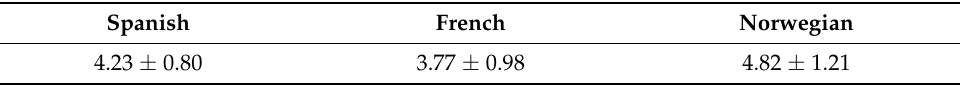
Table 8. Average response time and standard deviation per language, in